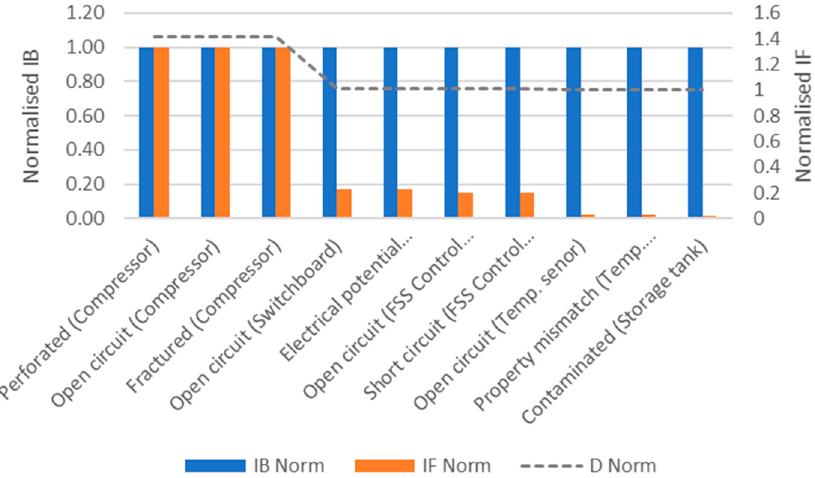
Figure 9. Severity assessment of faults.